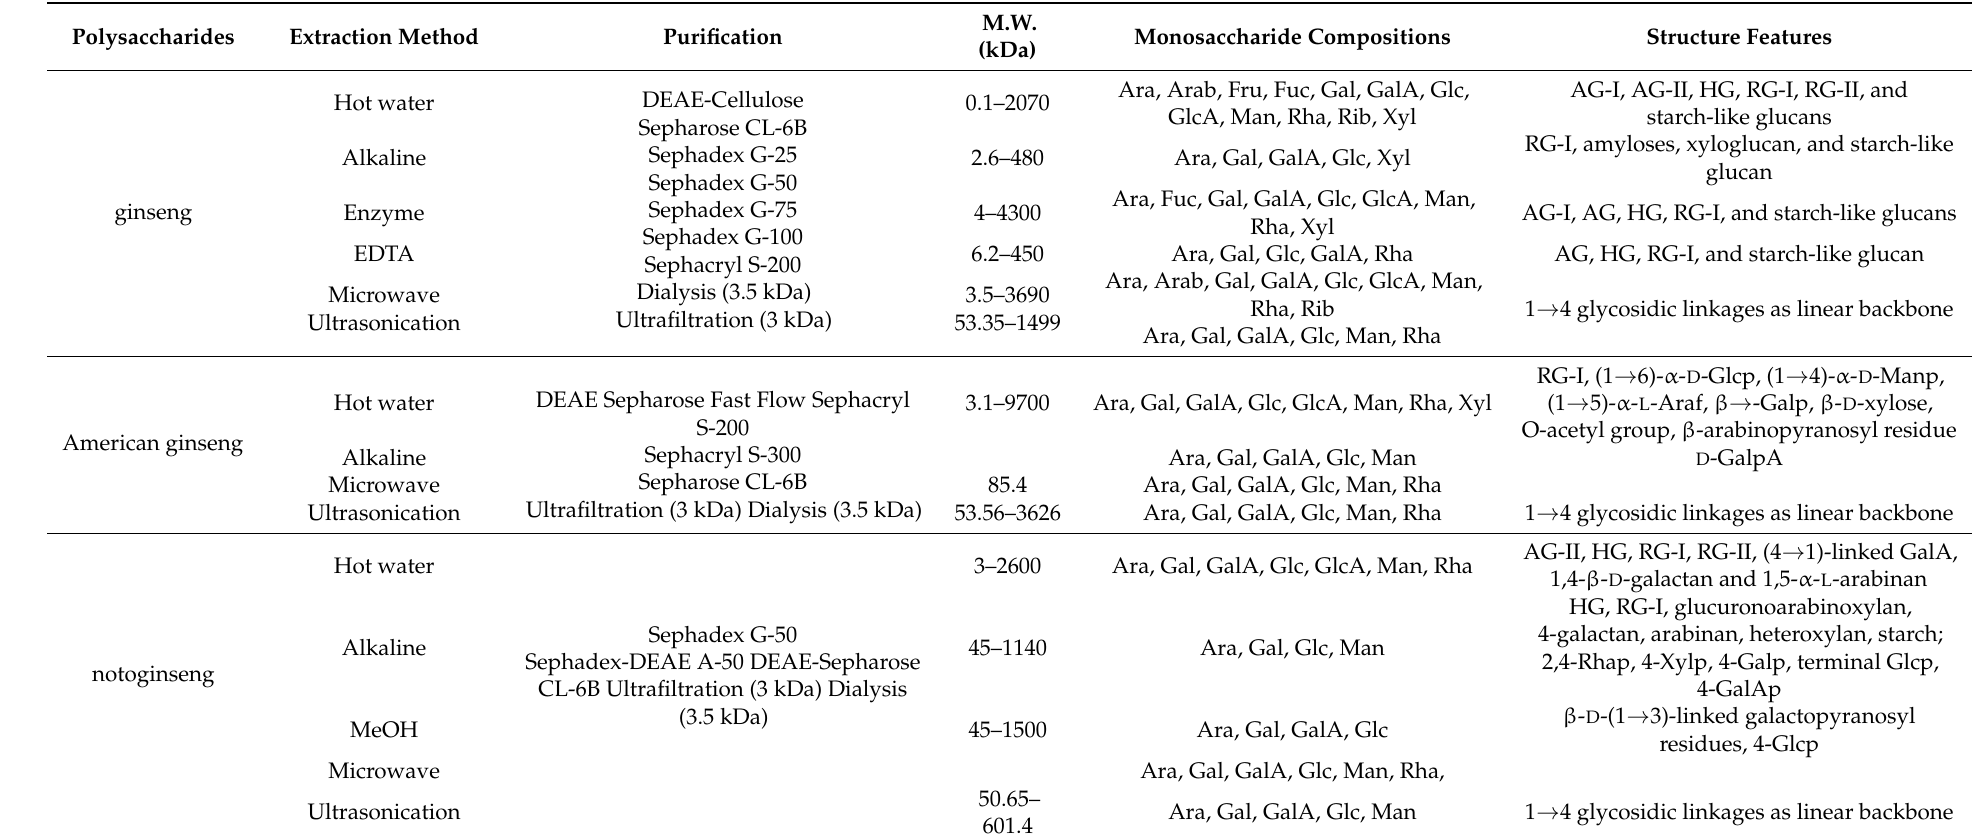
Table 4. Structure of ginseng, American ginseng and notoginseng